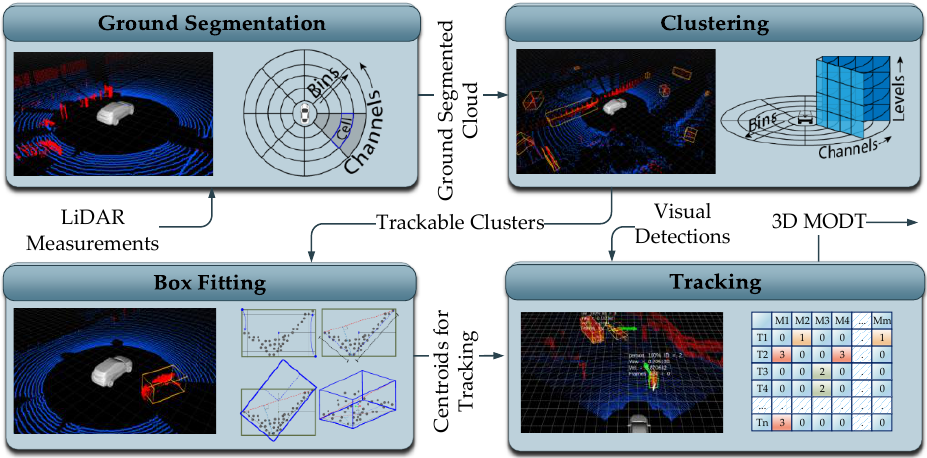
Figure 3. 3D MODT module in the proposed